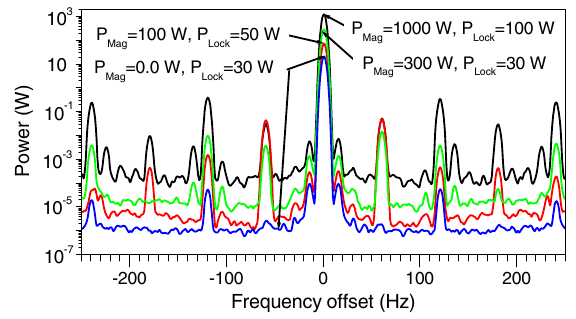
FIG. 8. Offset of the carrier frequency at various power levels of the magnetron, P , and the locking signal, P Mag P ¼ 0 . 0 W, P ¼ 30 W shows the frequency offset of the Mag Lock injection-locking